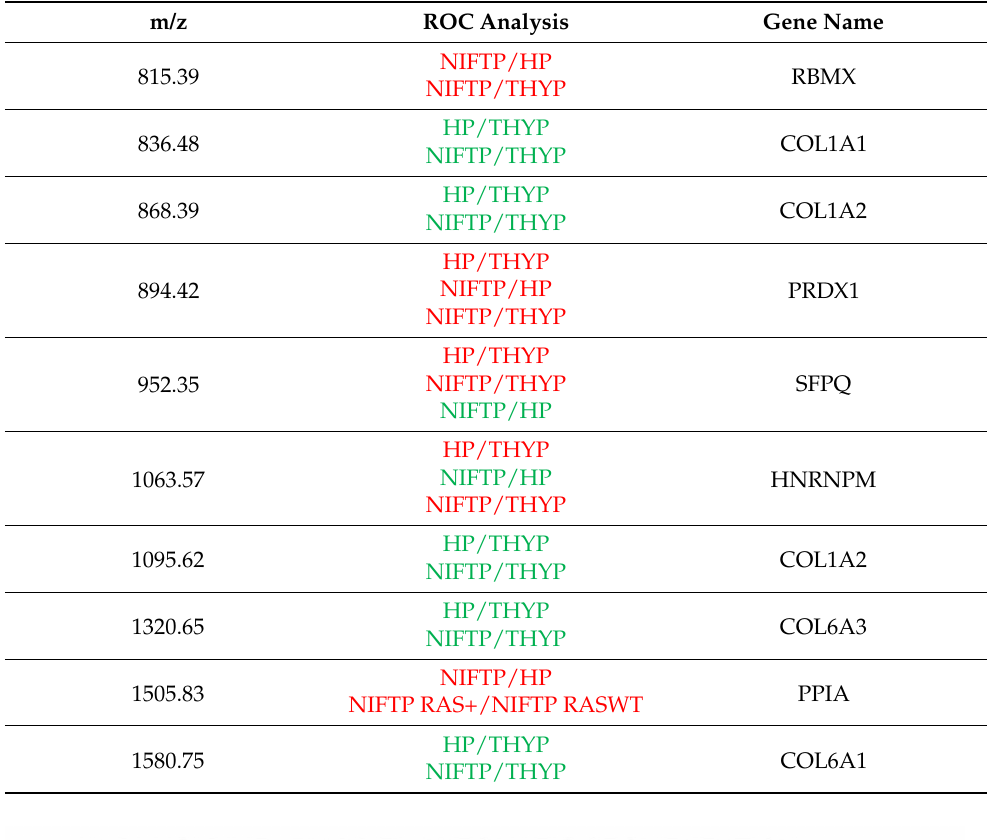
Table 2. List of the 10 uniquely identified signals used for automatic segmentation. Over-expressed peptides are highlighted in red, under-expressed ones in green. THYP: Surrounding not nodular thyroid parenchyma, HP: Hyperplastic.